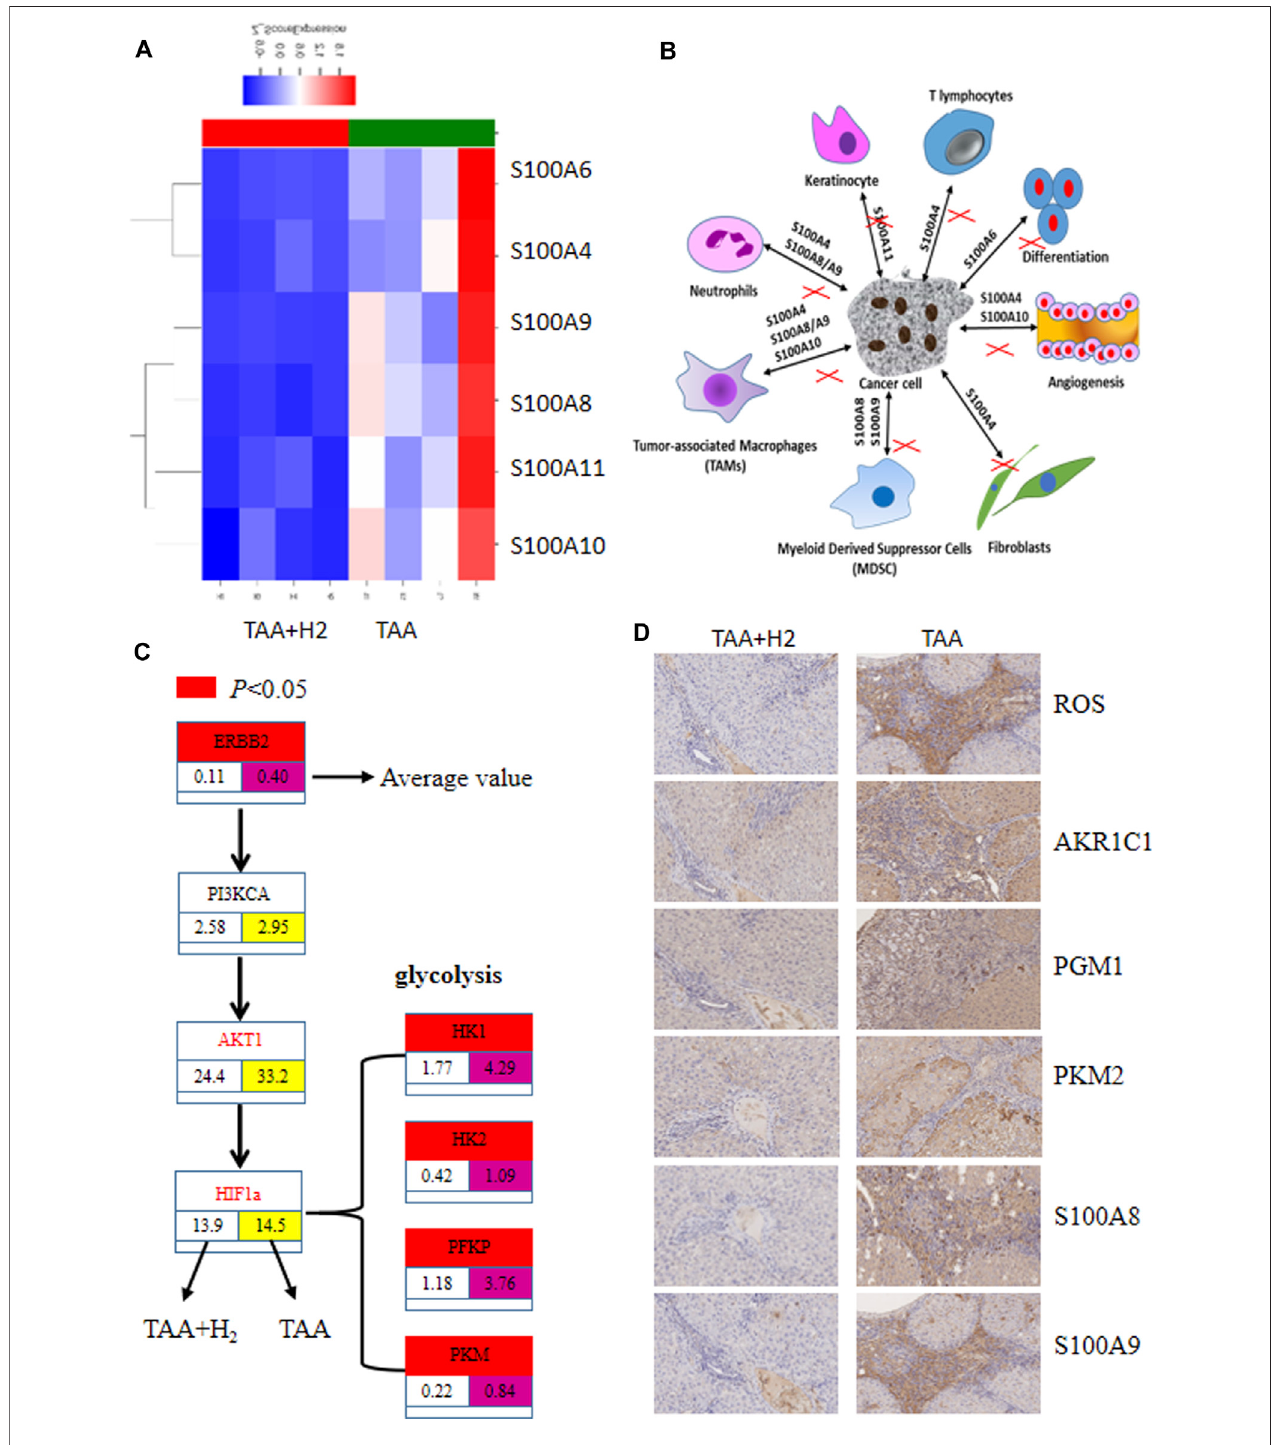
FIGURE 4 | RNA-seq analysis revealed differential gene expression between the livers from the TAA and TAA + H 2 groups. (A) Four livers from the TAA group and four livers from the TAA + H 2 group were subjected to RNA-seq analysis, and multiple members of the S100 gene family were highly expressed in the TAA group but showedlowexpression inthe TAA+H 2 group. (B) Schematic diagram oftheinteractionbetweencancercellsand stroma cellswhichcan beblocked byH 2 . (C) ERBB2 andrate-limitingenzymesinglycolysisweresigni fi cantlydecreasedbyH 2 treatmentcomparedwithnoH 2 treatment. (D) Immunohistochemistrywasusedtodetect the expression of ROS, AKR1C1, PGM1, PKM2, S100A8, and S100A9 on the liver samples from the TAA group and the TAA + H 2 group. IHC × 100.